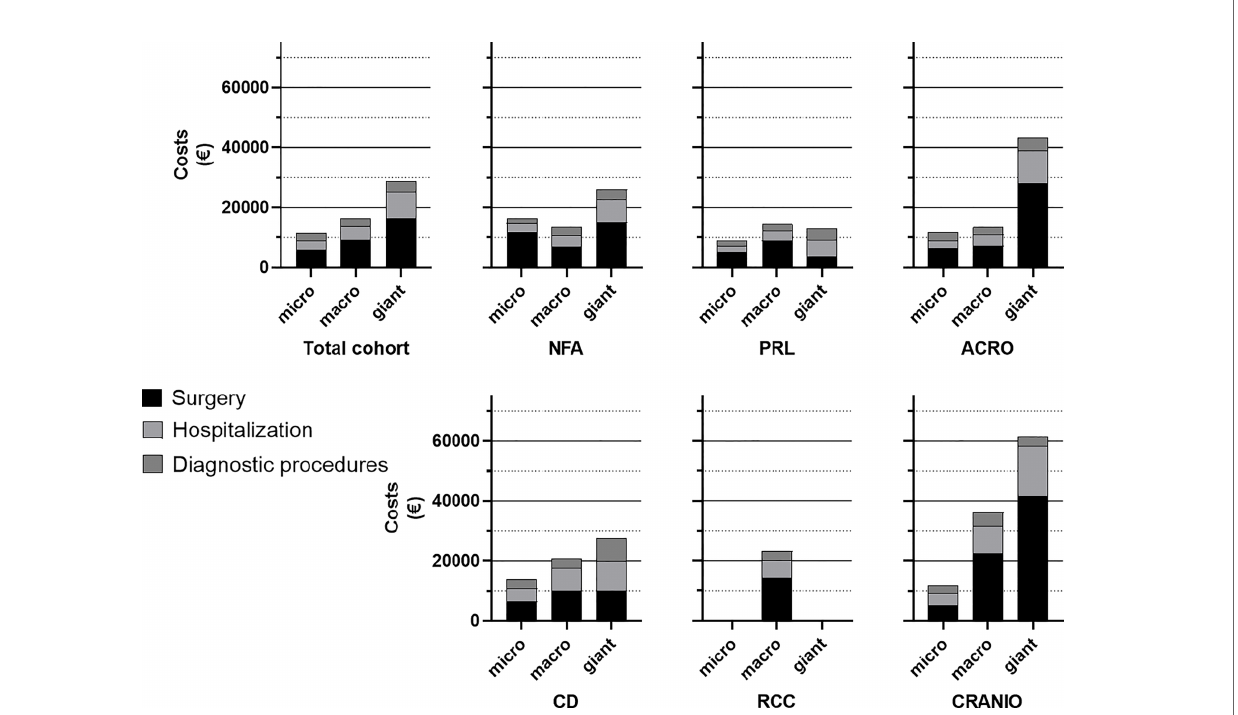
FIGURE 2 | Stacked bars displaying mean total costs of patients with different diagnoses and tumour size. For comparability, tumour size of patients with RCC or craniopharyngioma were also categorized as micro, macro or giant tumours. In most groups, surgery costs account for >50% of total costs and total costs increase with tumour size. NFA , non-functioning adenoma; PRL , Prolactinoma; ACRO , acromegaly; CD , Cushing ’ s disease; RCC , Rathke ’ s cleft cyst; CRANIO ,